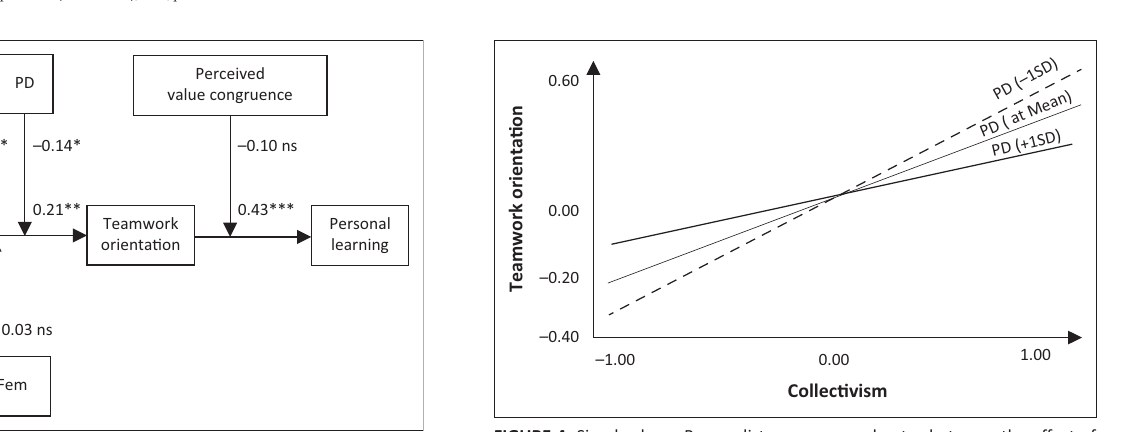
FIGURE 2: Results of structural model showing relative strength of the association between constructs.